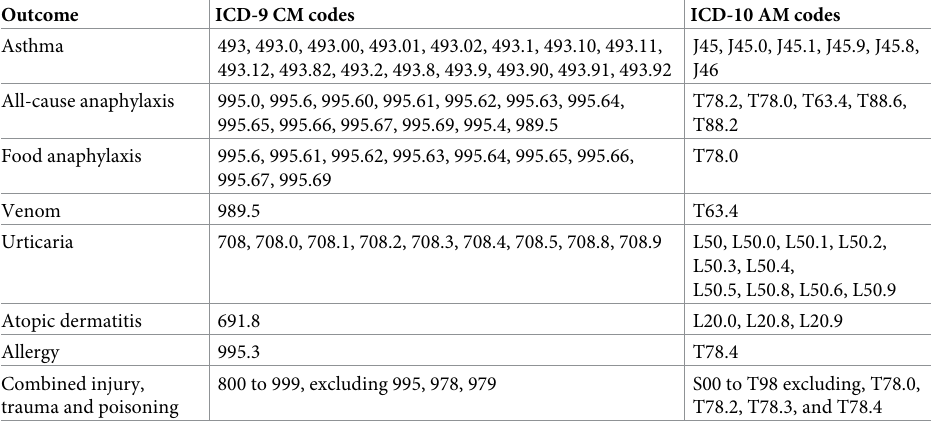
Table 1. ICD-9 CM and ICD-10 AM diagnostic codes of